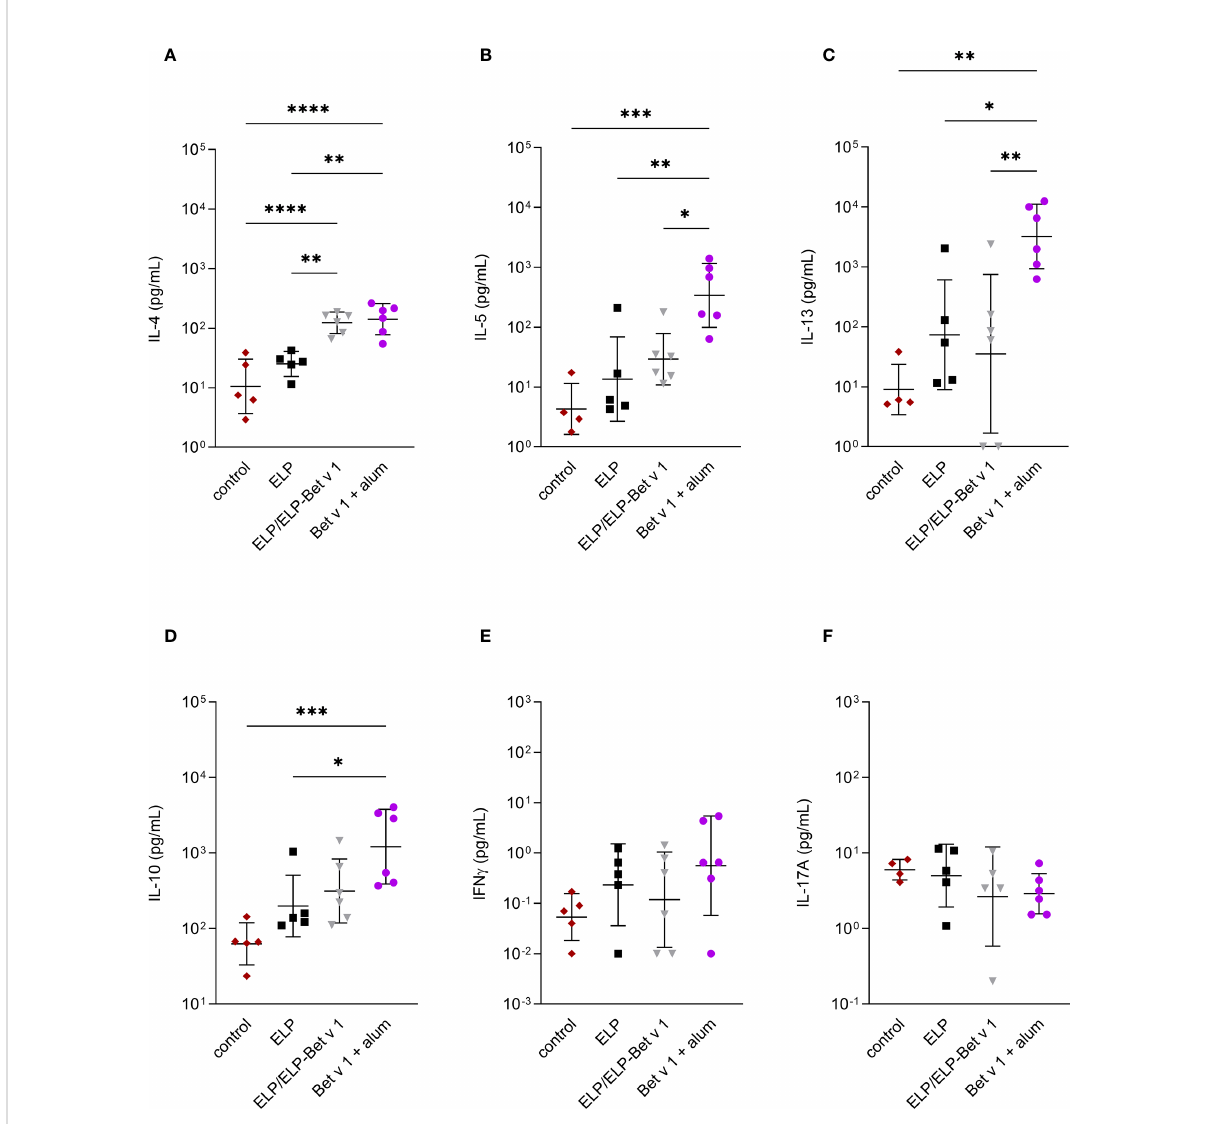
FIGURE 8 Cytokine expression in lymph node cultures. Expression of IL-4 (A) , IL-5 (B) , IL-13 (C) , IL-10 (D) , IFN- g (E) and IL17A (F) in ex vivo re-stimulated lung draining lymph nodes. *p<0.05, **p<0.01, ***p<0.001 and ****p<0.0001. Displayed are means ±